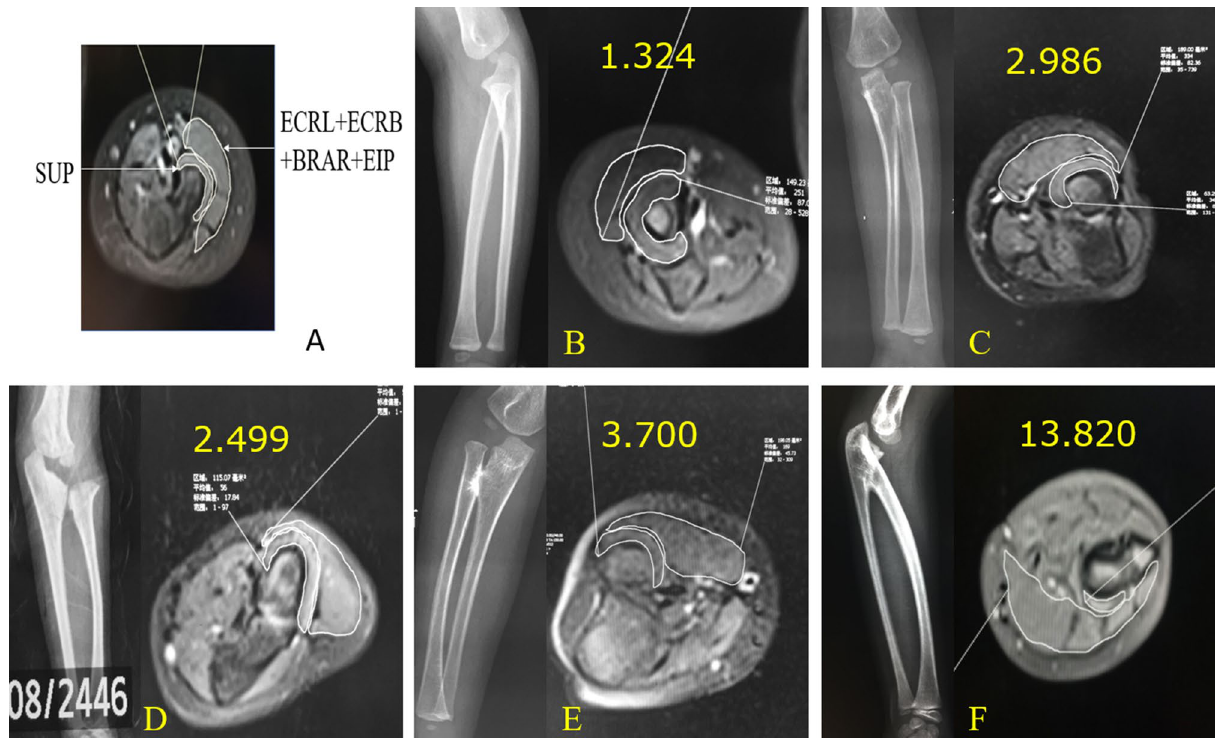
Figure 1. ( A ) The muscle selection of (ECRL + ECRB + BRAR + EIP) and supinator. ( B ) Radiography and MR image of the normal forearm with a supinator ratio of 1.324. ( C ) X-ray, MR image and supinator ratio of MRI & X-ray type I forearm, also classified as Cleary & Omer type I: Fibrous pseudo-synostosis with any shape of the radial head. ( D ) Radiography, MR image and supinator ratio of MRI & X-ray type I forearm, also classified as Cleary & Omer type IV. ( E ) Radiography, MR image and supinator ratio of MRI & X-ray type II: radiographic osseous synostosis with radial head dislocated. ( F ) Radiography, MR image and supinator ratio of MRI & X-ray type III, Tachdjian type I: radiographic radial head unobservable and osseous synostosis with the